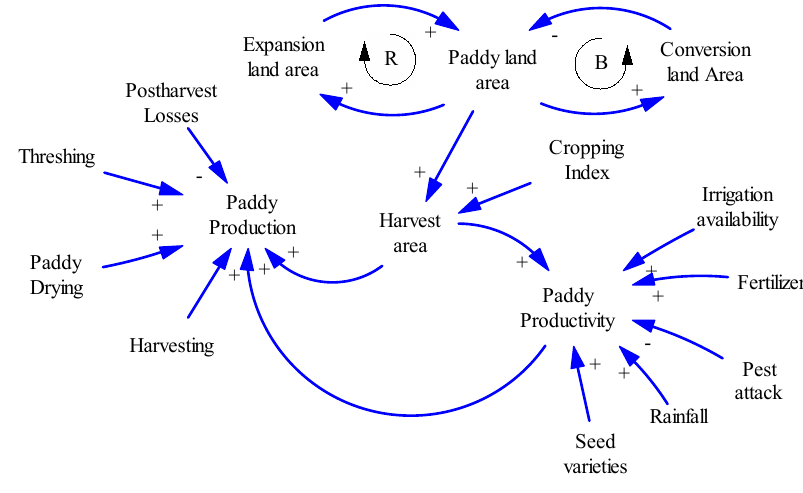
Fig.1 Causal loop diagram of paddy production